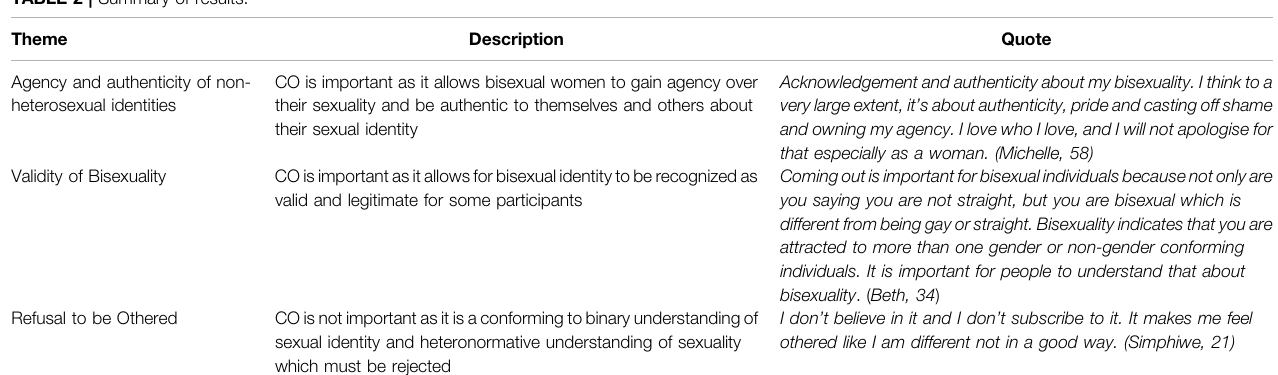
TABLE 2 | Summary of results. Theme Description Quote Agency and authenticity of non- heterosexual